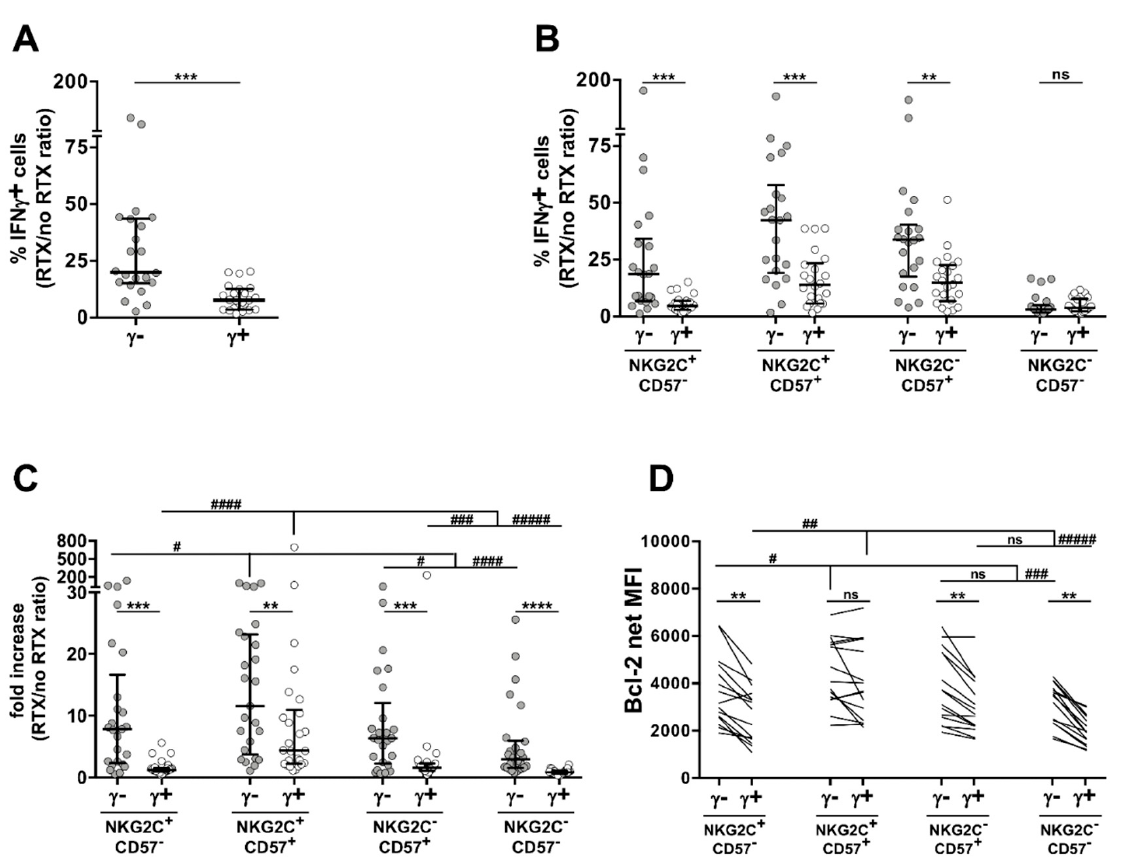
Figure 3. Fc ε RI γ − NKG2C + CD57 + subset enhanced functional responses to IgG-opsonized targets. ( A,B ) Percentage of IFN γ − producing cells upon short-term stimulation with Raji target cells, op- sonized or not with rituximab anti-CD20 mAb (RTX), was evaluated in freshly isolated peripheral blood Fc ε RI γ − (grey) and Fc ε RI γ + (empty) CD56 dim NK cells from HCMV + individuals ( A ), or after stratification according to NKG2C and CD57 expression ( B ). Data are expressed as the fold increase of IFN γ − producing cells in the presence vs. absence of rituximab (RTX/no RTX). Data are representative of 22 independent donors. Bars represent median with interquartile range. p values of pairwise comparisons were calculated by Wilcoxon non-parametric test. (**) = 0.001, (***) < 0.001. ( C ) Proliferation index of Fc ε RI γ − (grey) and Fc ε RI γ + (empty) CD16 + CD56 dim NK cell subsets, evalu- ated as the ratio between cell number fold increase in the presence vs. absence of rituximab (RTX/no RTX). Data are representative of 28 independent donors. ( D ) Bcl-2 content of Fc ε RI γ − and Fc ε RI γ + CD56 dim NK cell subsets. Data are expressed as net mean fluorescence intensity (MFI). Data are representative of 13 HCMV + healthy donors. ( C , D ) Bars represent median with interquartile range. p values of pairwise comparisons were calculated by Wilcoxon and Friedman non-parametric tests, as appropriate. For the sake of clarity, only comparisons with NKG2C + CD57 + subsets are reported, after Bonferroni correction. (*) symbol indicates statistical comparison with corresponding Fc ε RI γ + subset (Fc ε RI γ − vs. Fc ε RI γ + ): (**) < 0.005, (***) < 0.00005, (****) < 0.00001; (#) symbol indicates statistical comparison of NKG2C + CD57 + cells with the other subsets belonging to either Fc ε RI γ − or Fc ε RI γ + pools: (#) < 0.05, (##) < 0.005, (###) < 0.0001, (####) < 0.000005, (#####) < 1 × 10 − 7